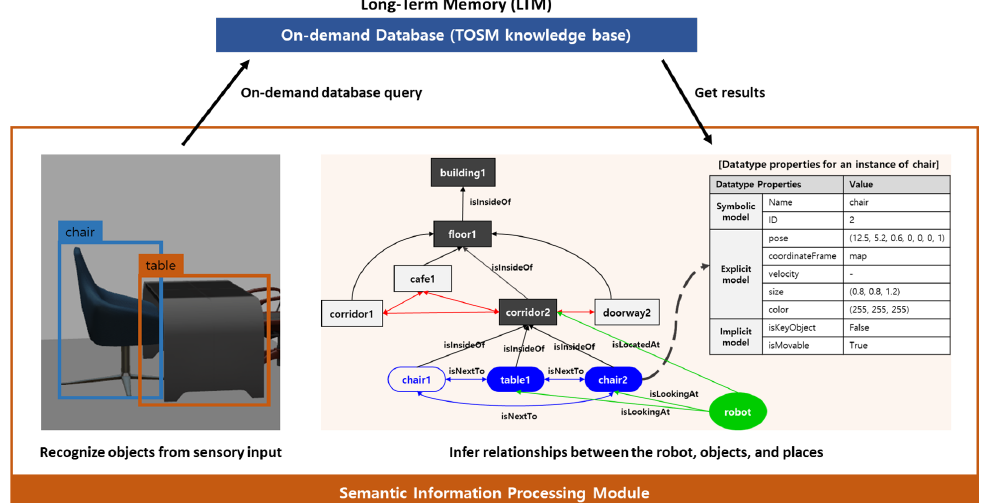
Figure 4. Semantic information processing